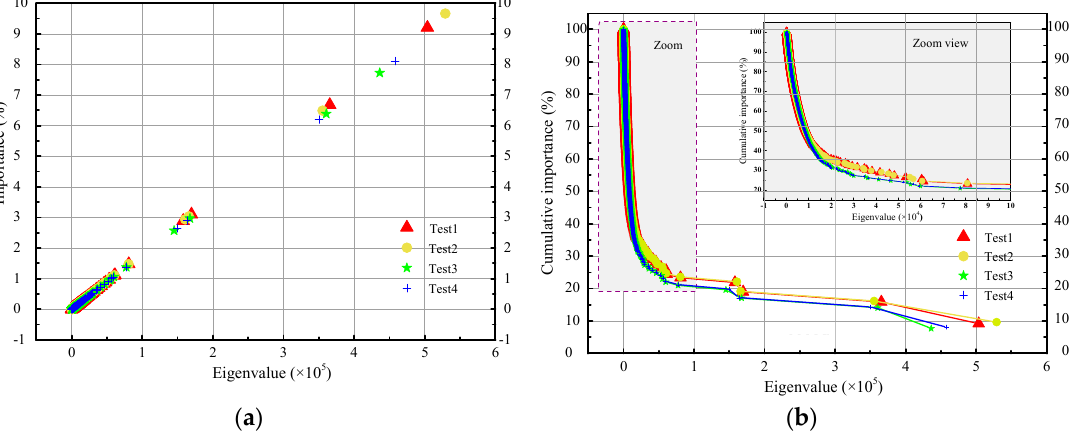
Figure 6. Importance and cumulative importance of the PCA derived eigenvalues for test 1 to test 4. ( a ) Importance of the PCA derived eigenvalues for test 1 to test 4. The red triangles, yellow circles, green stars, and blue crosses indicate the eigenvalues with specific importance for test 1 to test 4, respectively; ( b ) Cumulative importance of the PCA derived eigenvalues for test 1 to test 4. The red line with triangles, yellow line with circles, green line with stars, and blue line with crosses represent the cumulative importance curves for test 1 to test 4, respectively. The zoom view shows the cumulative importance curves when the eigenvalue is between 1 × 10 4 and 10 × 10 4 .